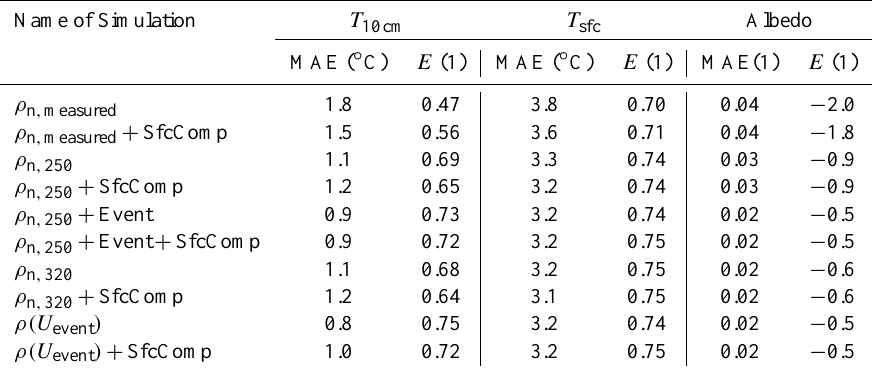
Table 4. Values of mean absolute error (MAE) and modified coefficient of efficiency ( E ) for snow temperature at 10-cm depth (19 Febru- ary 2008–20 March 2008, n = 728), snow surface temperature (4 May 2007–18 February 2009, n = 13834) and albedo (summer months between May 2007 and February 2009, 10a.m.–2p.m.LT, n =